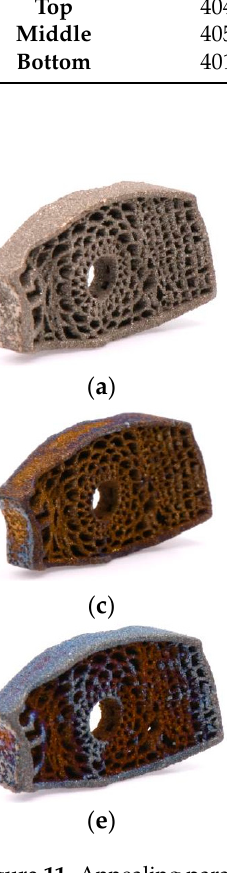
Figure 11. Annealing parameters ( a ) 450 °C/120 min; ( b ) 490 °C/240 min;( c ) 530 °C/80 min; ( d ) 570 °C/200 min;( e ) 610 °C/40 min;( f ) 650 °C/160 min. Table 9. Overall hardness for each specimen.